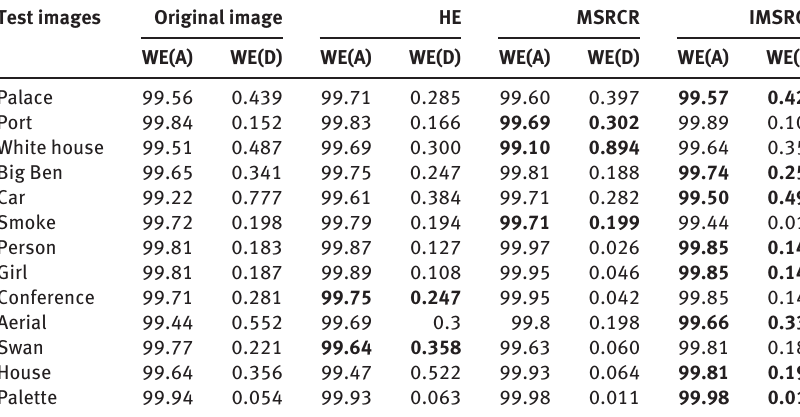
Table 2. Approximate (A) and Detailed (D) WE Metric for Color Image